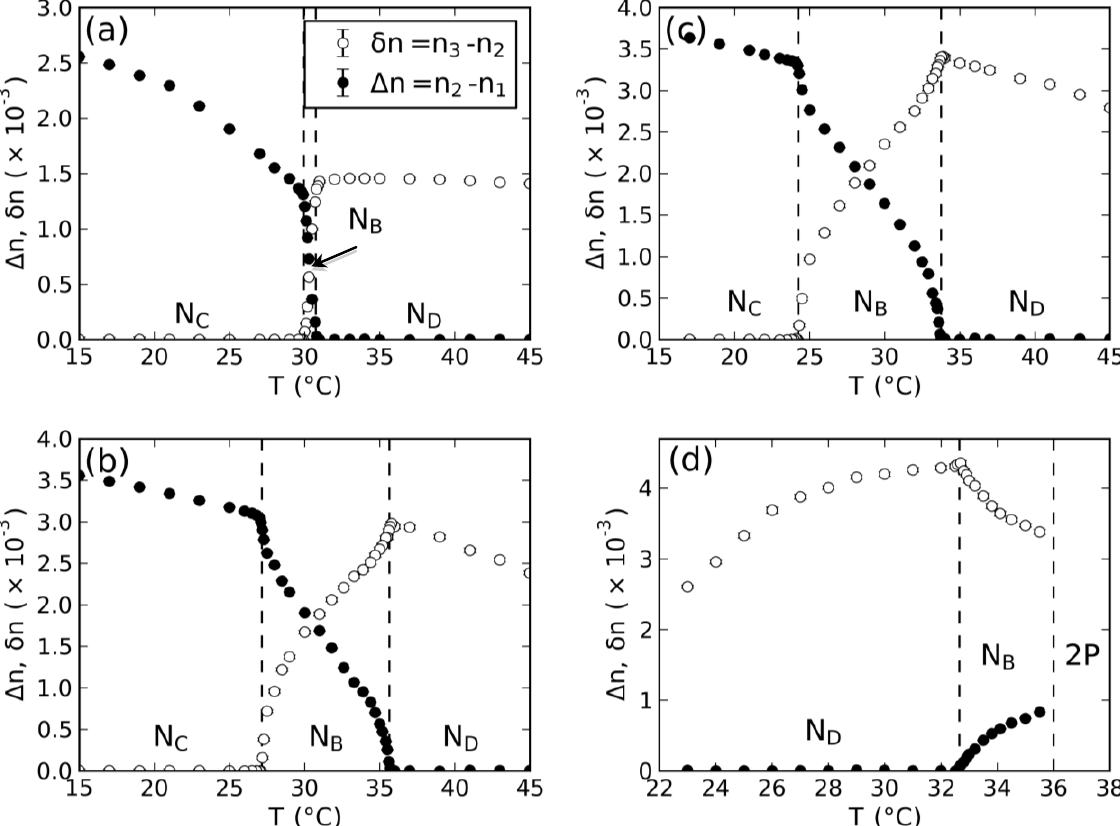
SO /DDeOH/water; ( b ) DL -KDDS/Na 2 4 SO /DDeOH/water; and ( d ) disodium 2 4 SO /UndeOH/water. 2P represents a two-phase 2 4